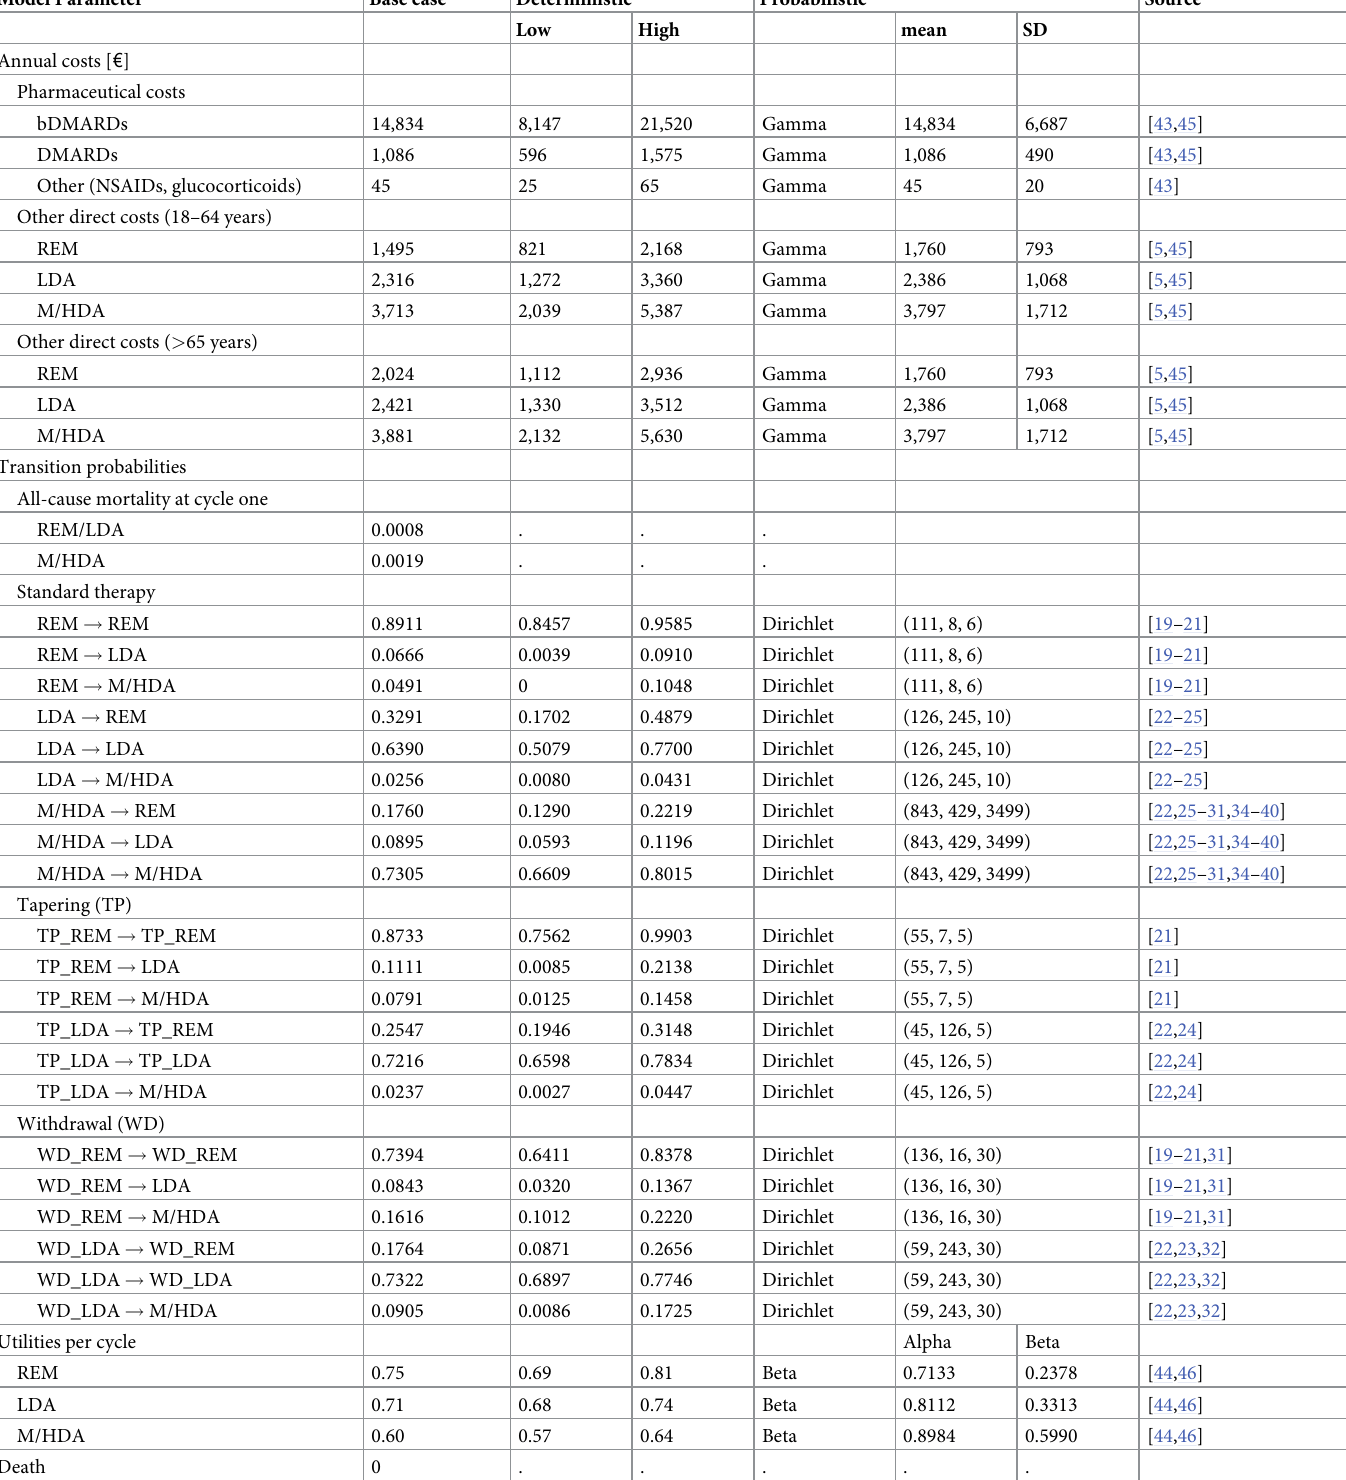
Table 2. Model parameters. Base case model parameters, upper and lower bounds for deterministic sensitivity analysis and distribution parameters for probabilistic sen- sitivity analysis. Model